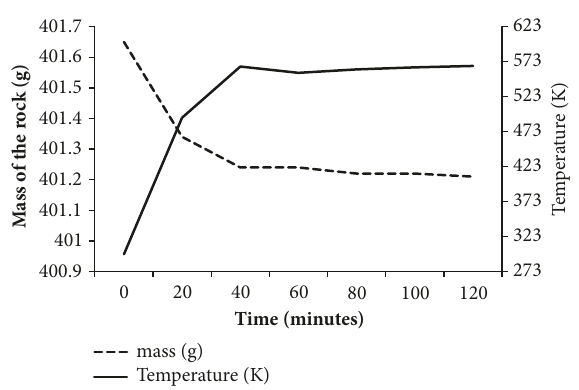
Figure 1: Relationship between mass of granite rock and tempera- ture with